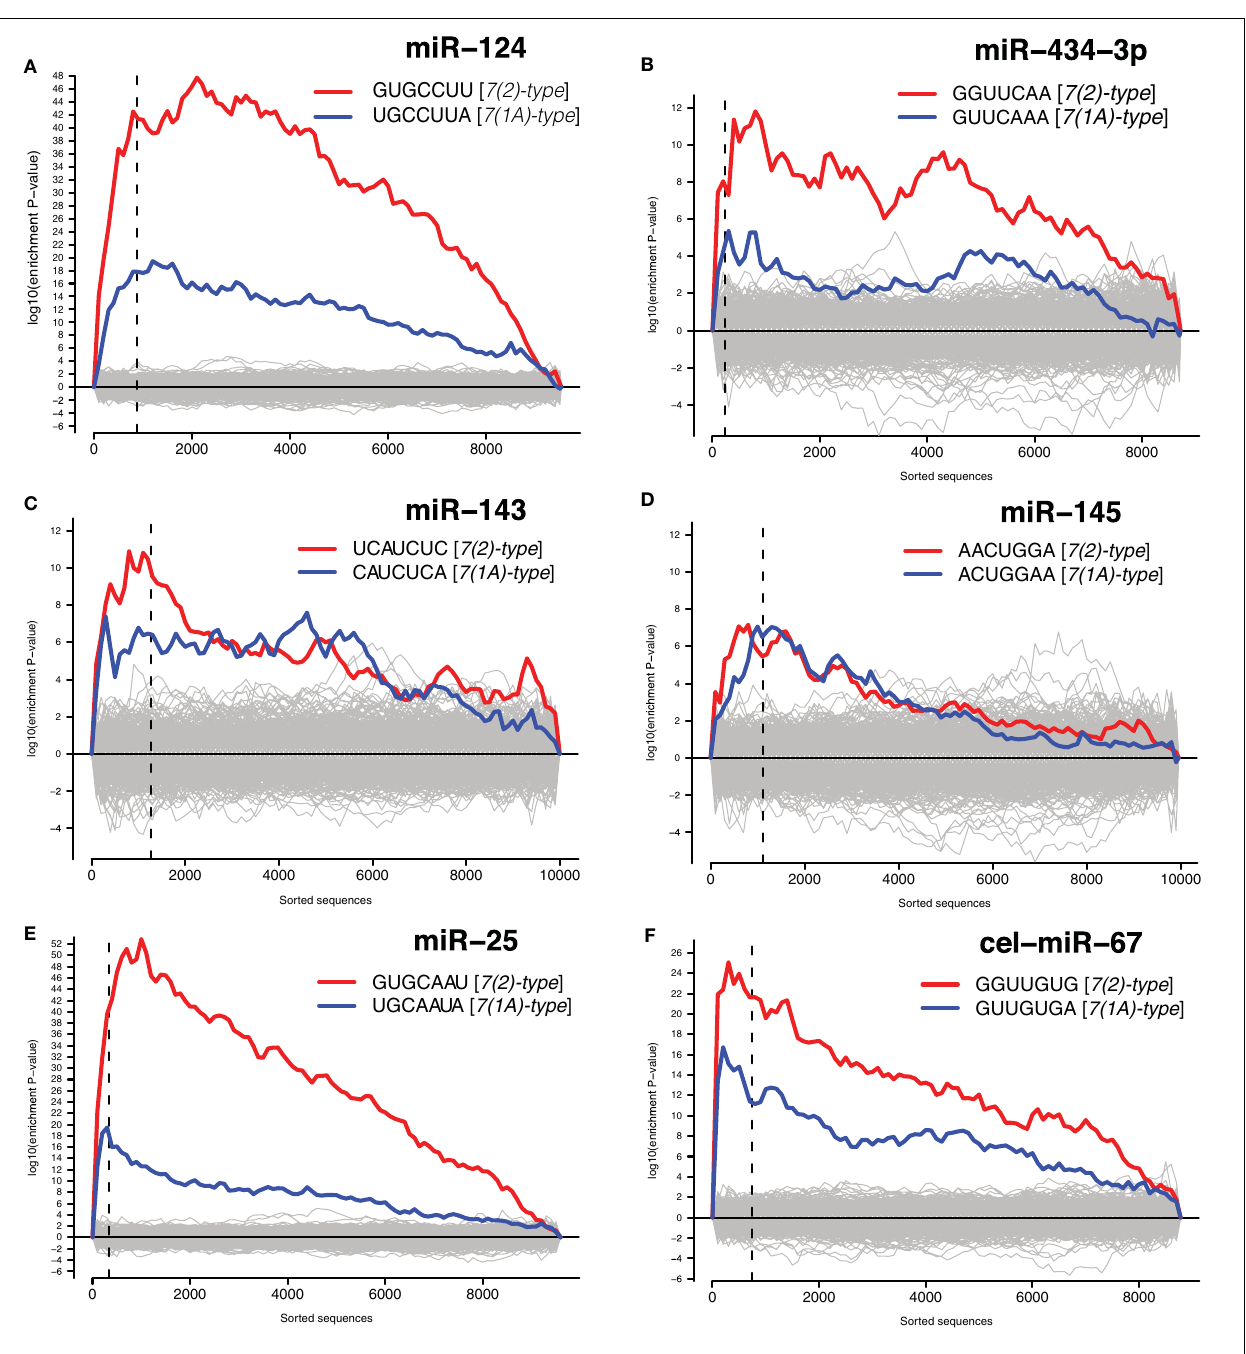
cultures. Sequences to the left of the vertical dashed lines correspond to genes downregulated with differential expression adjusted P < 0.05. Putative targets of miRNAs are defined as downregulated genes (adjusted P < 0.05) encoding transcripts with one or 7(2) or 7(1A)-type seed matching sites (Bartel, 2009) in 3 (cid:48) UTRs. Section “Materials and Methods” for